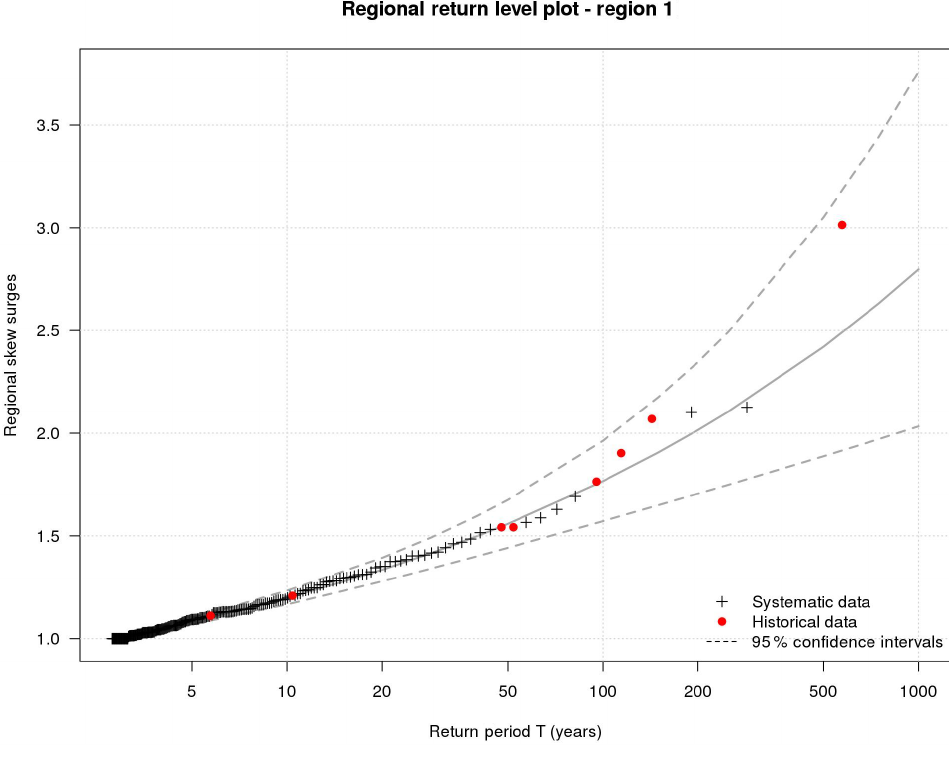
Figure 7. Return level plot for the regional distribution of Region 1 with the confidence intervals of 95% estimated by bootstrap. Red points represent the regional historical data and black crosses the regional systematic